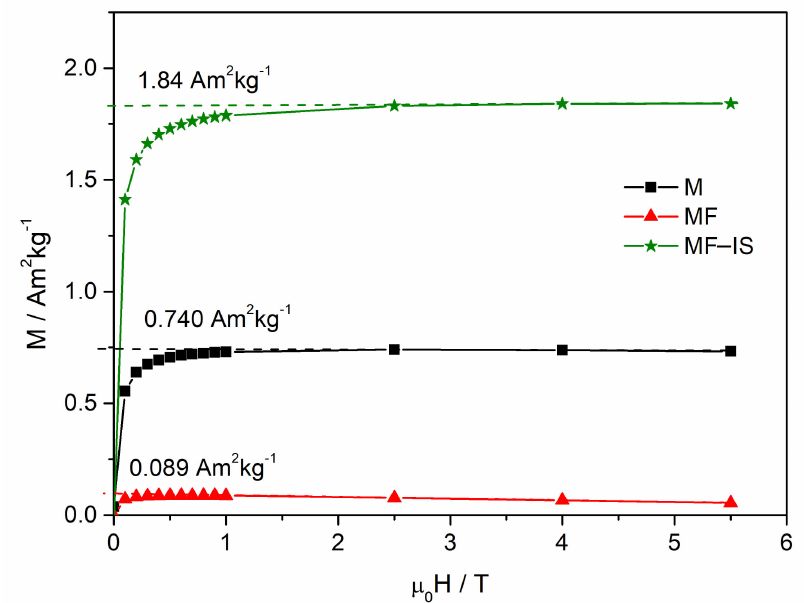
Figure 5. Magnetisation curves M(H) of magnetite (M), post-synthesis fucoidan-coated magnetite (MF), and in situ fucoidan-coated magnetite (MF −